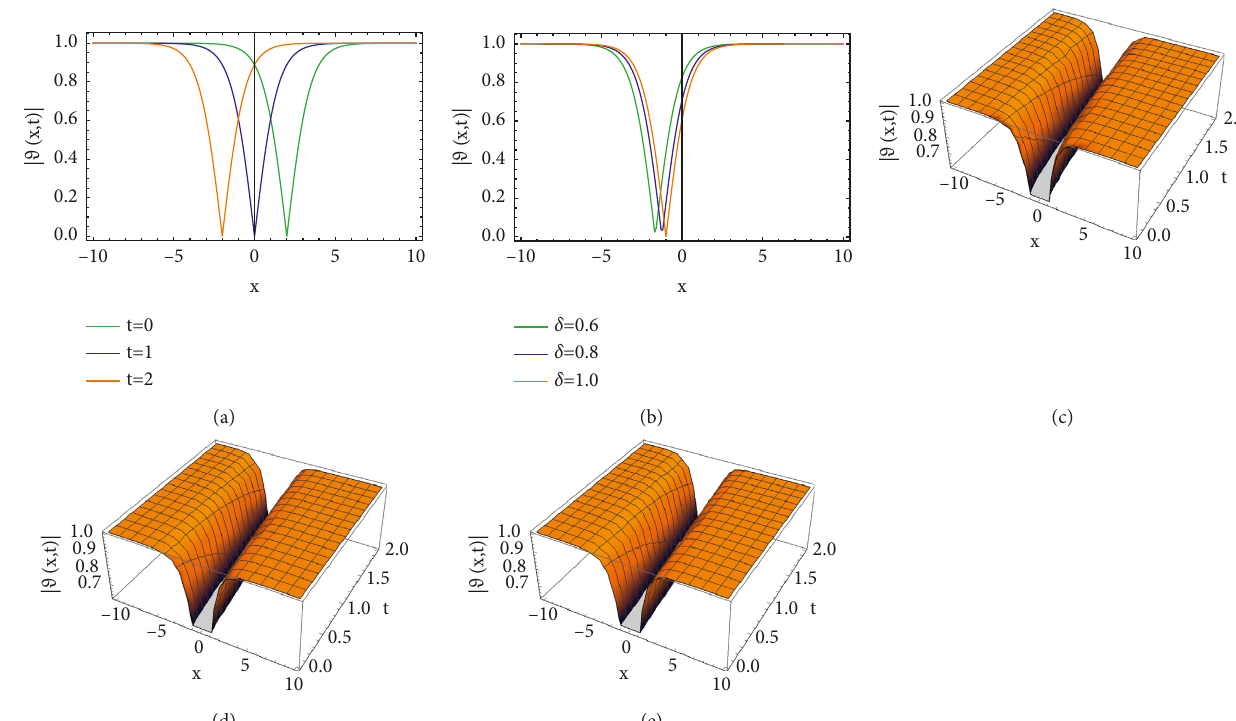
Figure 4: Solitary wave profile of ϑ